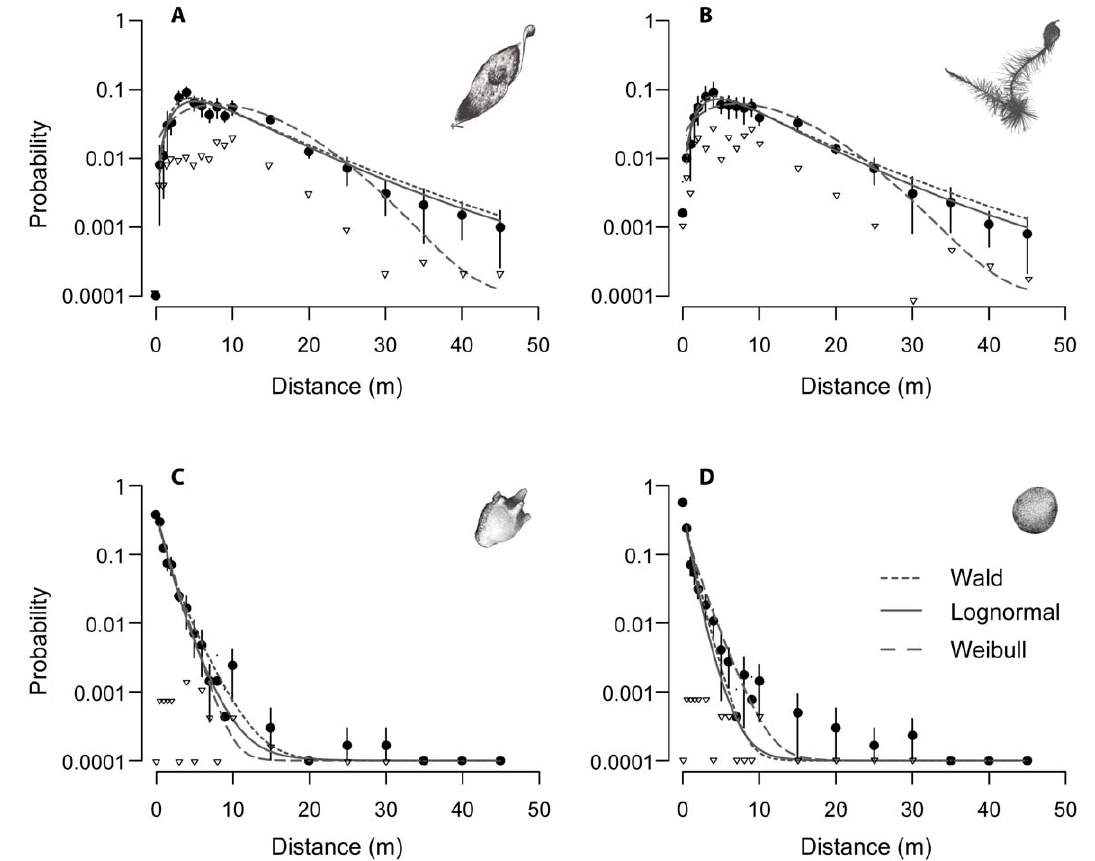
Figure 2. Probability distributions of seeds along the study road after 80 vehicle passes. (A) Ailanthus altissima (B) Clematis vitalba , (C) Ambrosia artemisiifolia and (D) Brassica napus . Filled circles represent the mean ( 6 95% CI) probabilities of 10 replicates. The grey lines show the fitted dispersal functions. Open triangles show mean probabilities for seeds to reach the road verge at that distance along the line of travel. The y-axis is on a log scale and 0.0001 was added to all probabilities to show zero values. Note that this is not a total dispersal kernel but solely shows secondary dispersal by car’s airflow.